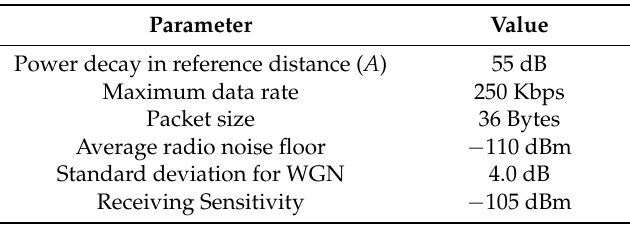
Table 5. Simulation